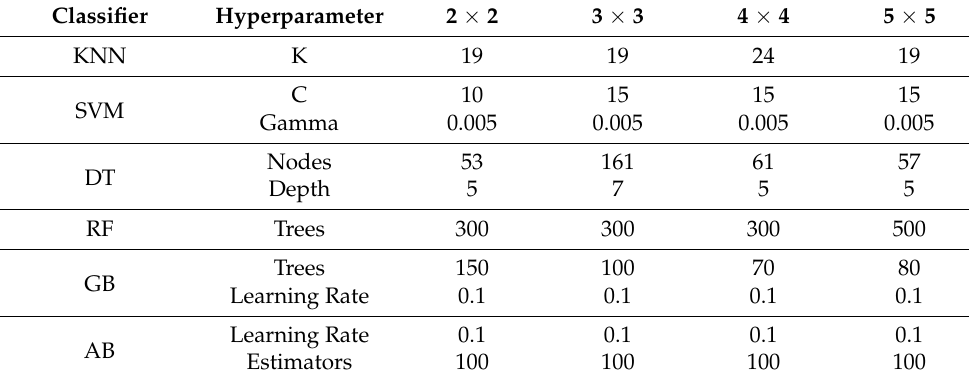
Figure 4. Sample script integrated user input space for model training. Table 4. Automatically tuned